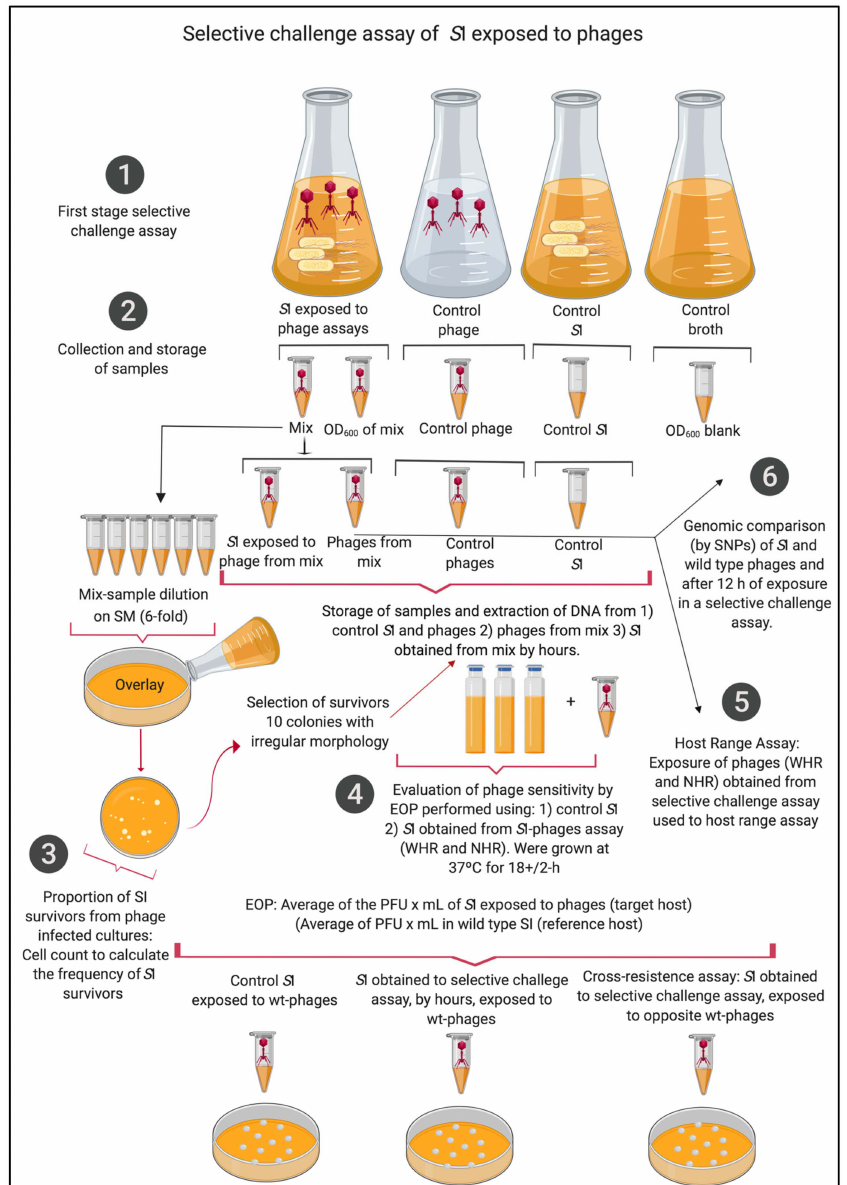
Figure 1. Selective challenge assays of S. Infantis exposed to wide- and narrow-host-range phages (WHR and NHR) at 12 h exposure. This assay was developed following the steps: ( 1 ) first stage selective challenge assay, ( 2 ) collection and storage of samples, ( 3 ) calculation of proportion of S I survivors from phage-infected cultures, ( 4 ) evaluation of phages susceptibility by e ffi ciency of plating (EOP), ( 5 ) host-range assay, and ( 6 ) genomic comparison by nucleotide polymorphism (SNPs) of S. Infantis and phages at 12 h